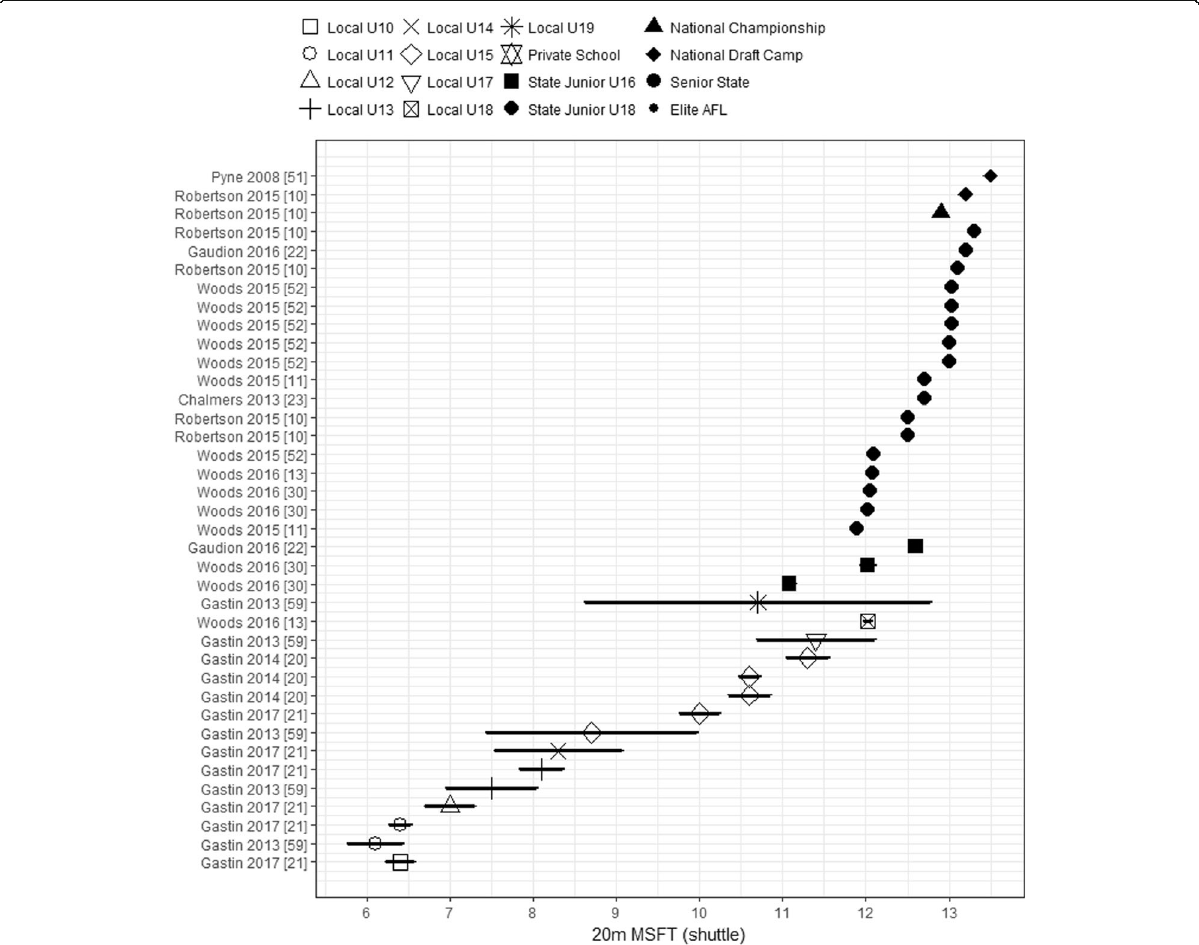
Fig. 6 Mean and CIs of 20-m MSFT shuttles reached by levels across the local participation and talent pathways. Values are ordered by position in AFL participation pathway, then by sample size reported for each group. All players ’ levels are shown in the legend for consistency though not all levels may have data on the charted performance measure. AFL Australian Football League, MSFT multi-stage fitness test, U